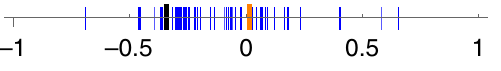
FIG. 4. Illustrating the advantage of overdetermined systems of equations. The same variational circuit as in Fig. 3 with all parameters optimal except for a single variable, which is disturbed as θ ¼ 0 . 5 , and, thus, the exact root is at θ ⋆ ¼ 0 . Blue lines show single-variate Newton steps computed for 100 θ , and their average is individual covariance functions θ þ Δ k represented by the black line. With the orange line, we obtain a 176 over- better approximation of the root by solving a N c ¼ determined system of linear equations (see the main